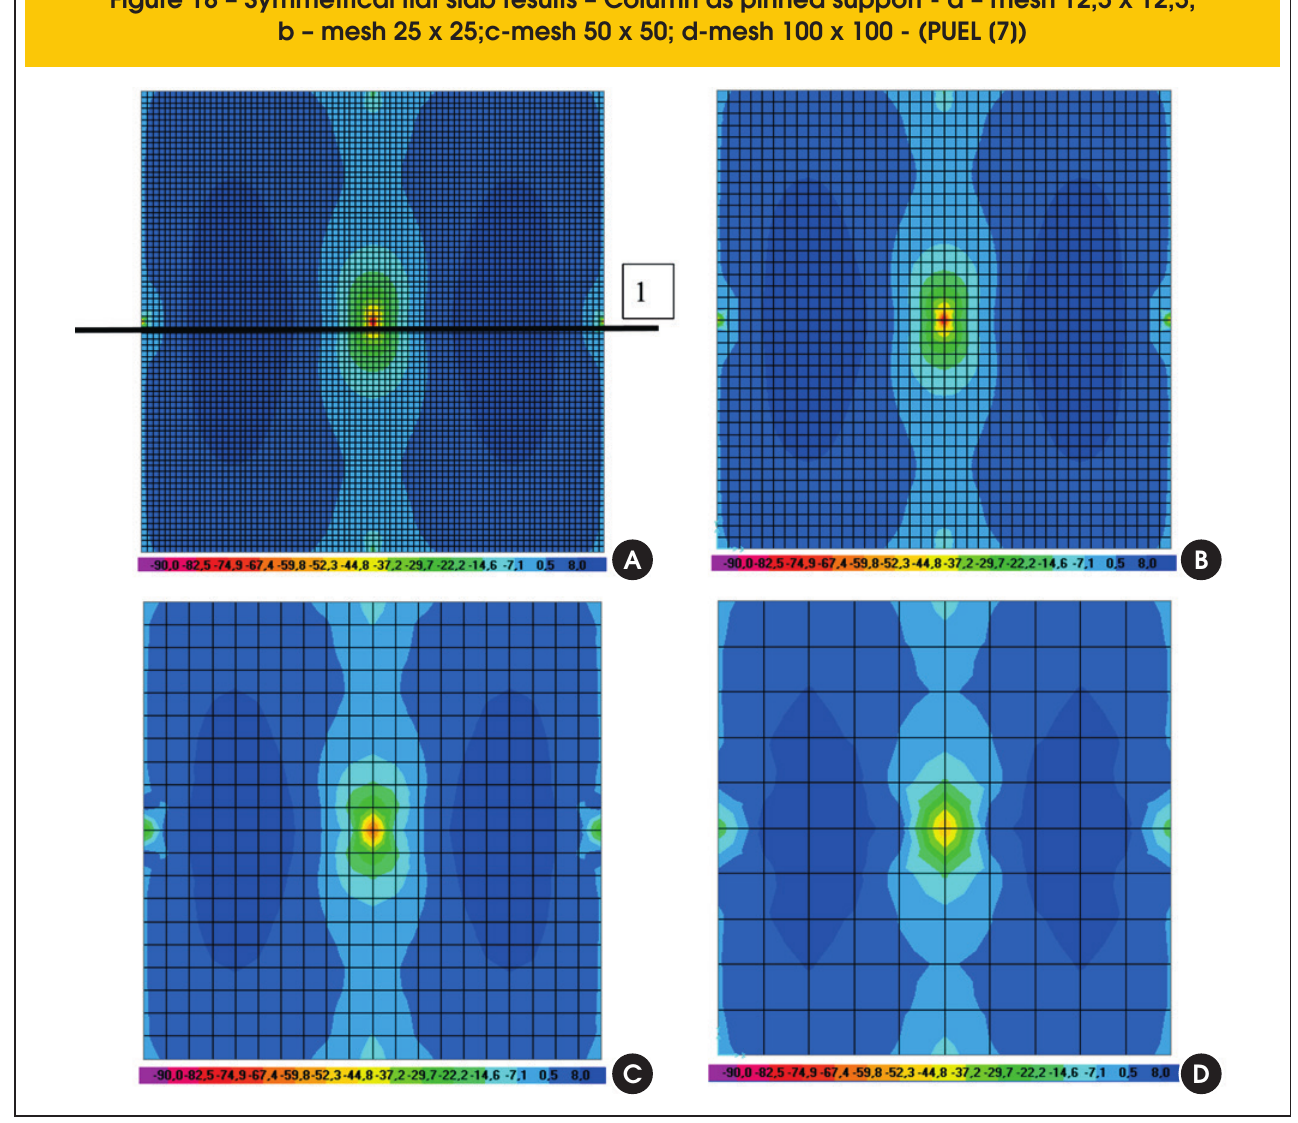
Figure 18 – Symmetrical flat slab results – Column as pinned support - a – mesh 12,5 x 12,5; b – mesh 25 x 25;c-mesh 50 x 50; d-mesh 100 x 100 - (PUEL